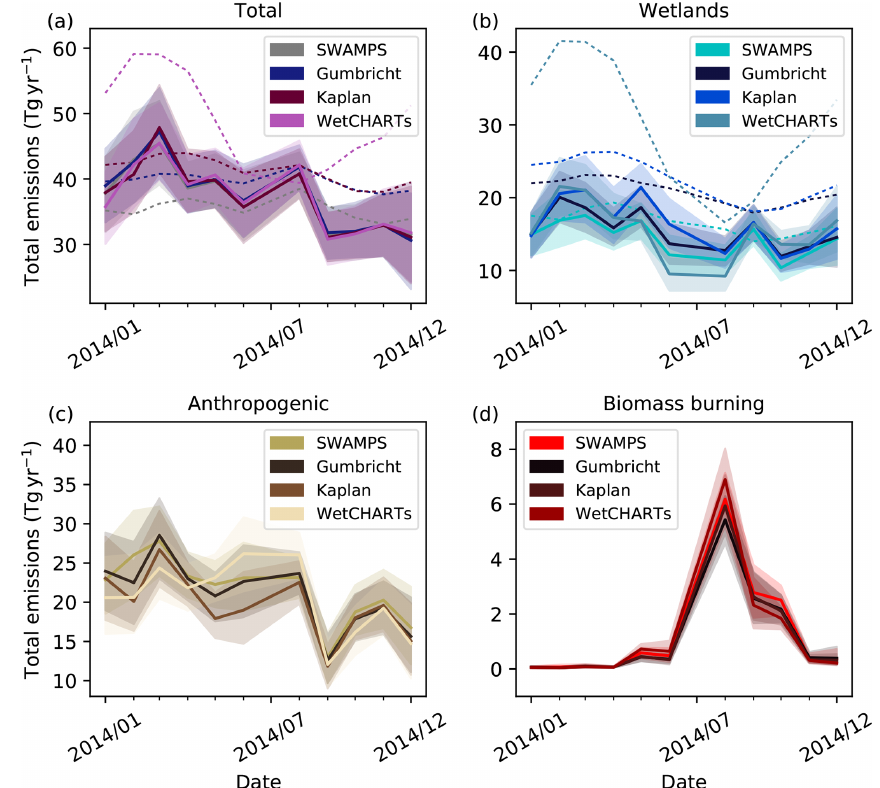
Figure 9. Brazil’s CH 4 emissions in a sensitivity inversion using perturbed a priori wetland distributions. All other components were held at the original configuration. Total emissions for all of South America were scaled to 44Tgyr − 1 for all distributions apart from WetCHARTs, which used its derived emissions. (a) Total, (b) wetland, (c) anthropogenic and (d) biomass burning emissions. Prior emissions are only shown in (a, b) as they only vary for these components in this